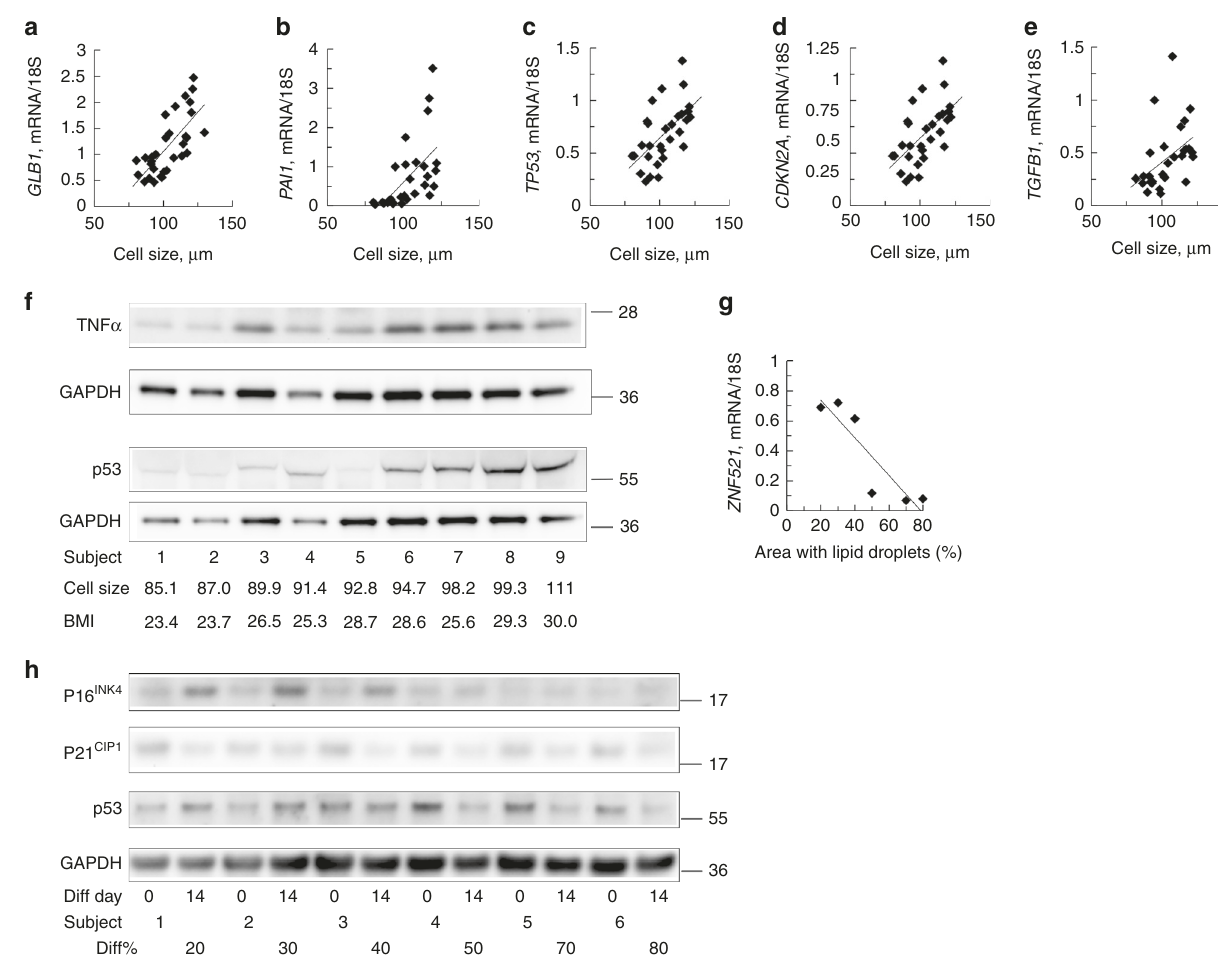
Fig. 4 Gene and protein levels of senescence markers are increased in hypertrophic obesity. a – e Correlation of senescence markers and cell size in fresh SAT biopsies from lean, obese and obese T2D, GLB1 ( P < 0.001), PAI1 ( P < 0.001), TP53 ( P < 0.003), CDKN2A/P16 INK4 ( P < 0.001), and TGFB1 ( P < 0.01), n = 28 biological independent samples. Comparisons were made with Spearman ’ s correlation coef fi cient. f Immunoblots of p53 and TNF α in SAT biopsies. g ZNF521 mRNA was reduced in cells with good differentiation measured as area with lipid droplets. Individuals from h . h Immunoblot from six individuals with different degree of differentiation. SVF cell were differentiated 14 days. a – e mRNA expression was fi rst normalized to 18 S and then normalized to expression in undifferentiated sample ( = cells, i.e. hypertrophic obesity, is a marker of this 4,30 . Importantly,